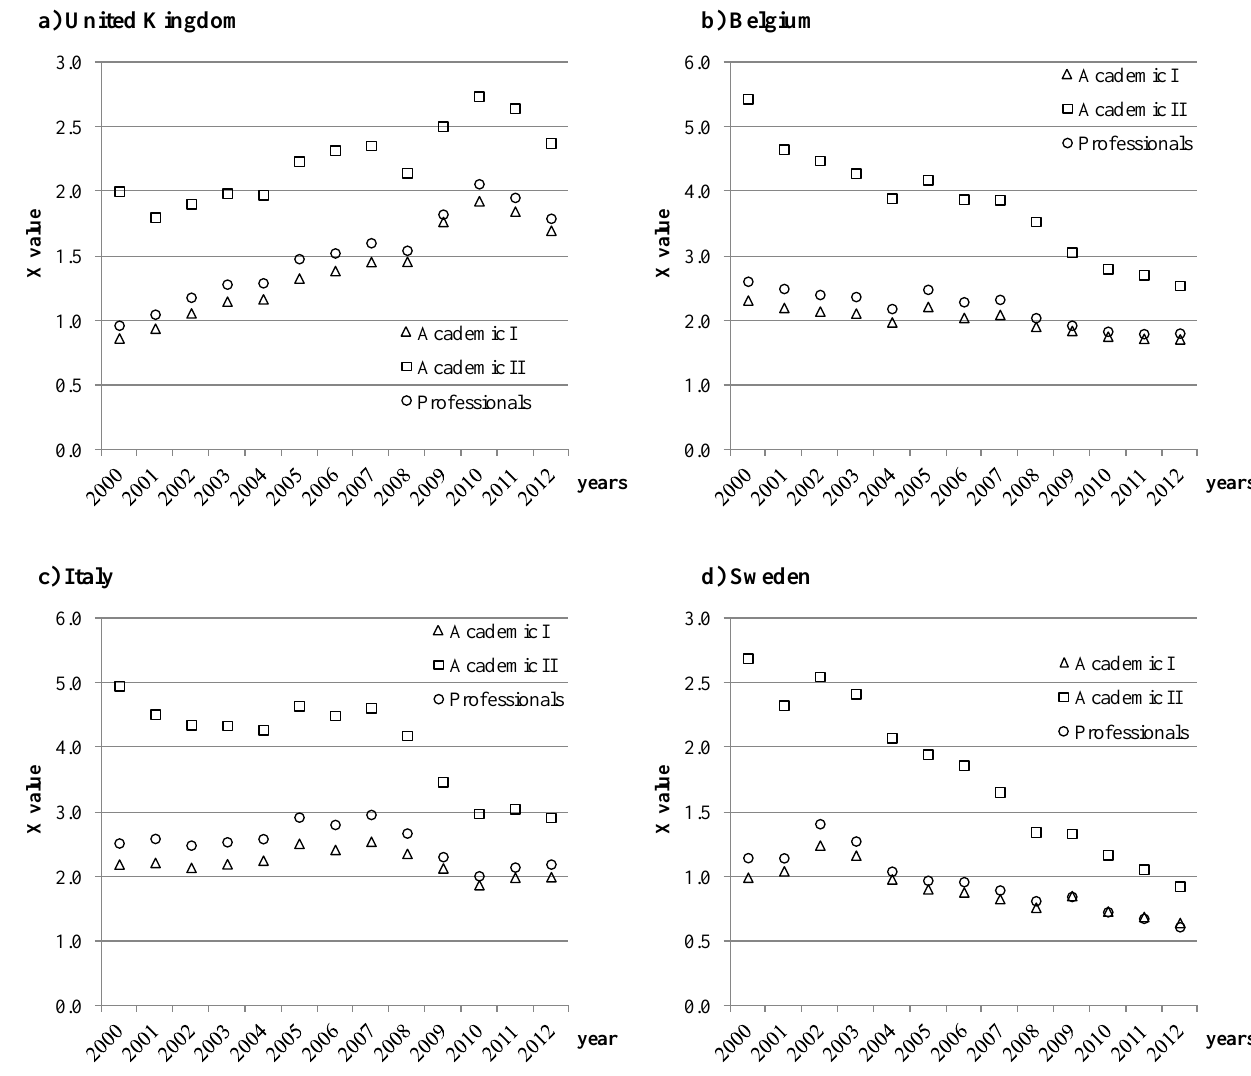
Fig. 3. Values of the consolidated indicator of the state financial stability for the selected EU countries calculated using weight coefficients from different expert